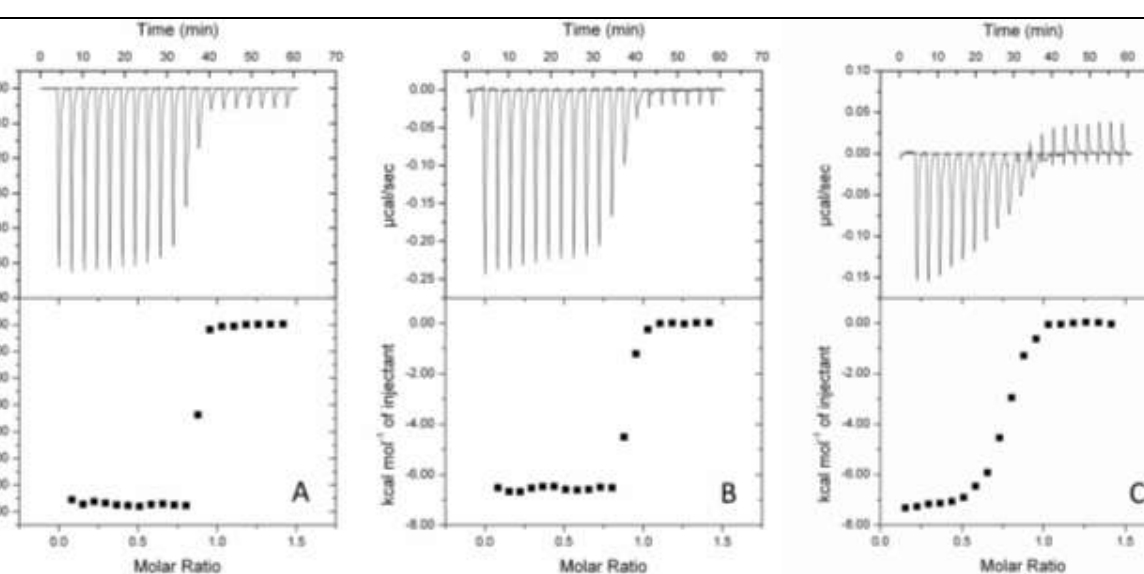
Figure 5. Isothermal titration calorimetry of ligand binding to TupA. TupA (10 µM) was titrated with injections of 100 µM tungstate ( A ) and 100 µM molybdate ( B ); ( C ) Displacement titration of 10 µM TupA incubated with 0.5 nM molybdate, with injections of 100 µM tungstate. Data were fitted with ORIGIN software. The raw ITC data are shown in the top graphs.